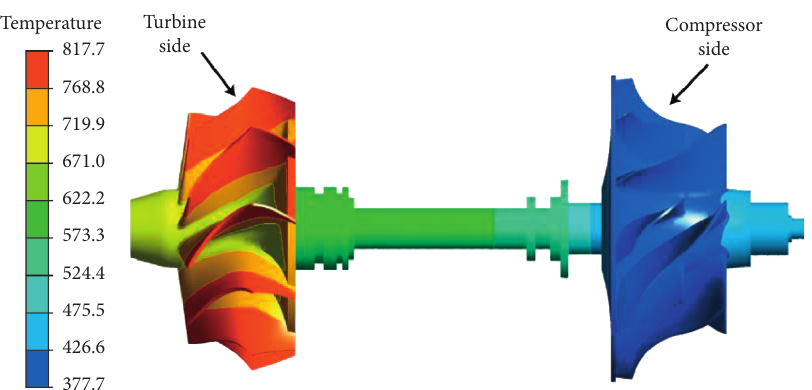
Figure 13: Postprocessing rotor temperature distribution.